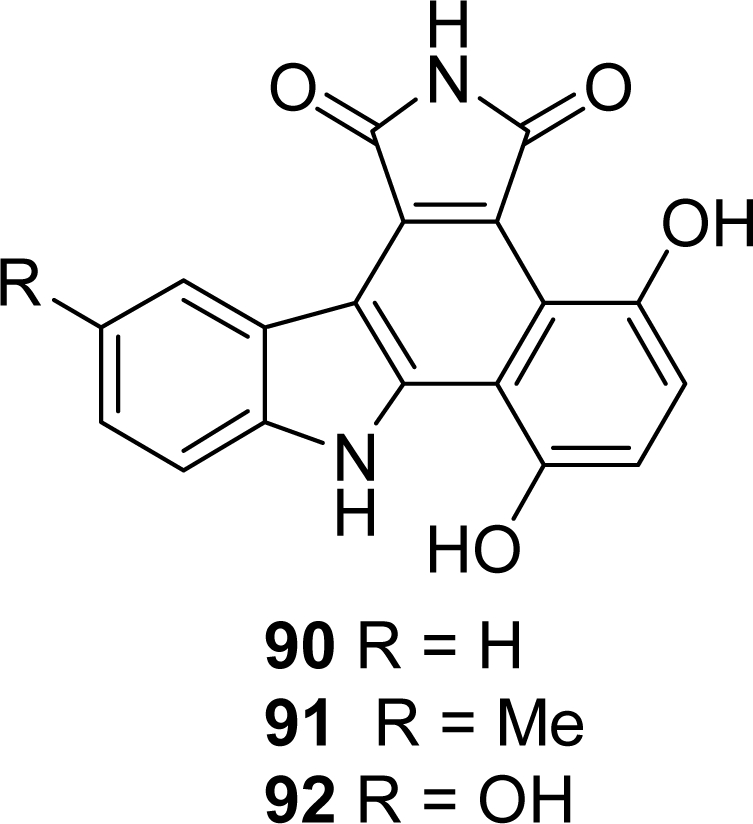
Dihydroxyphenylcarbazoles.